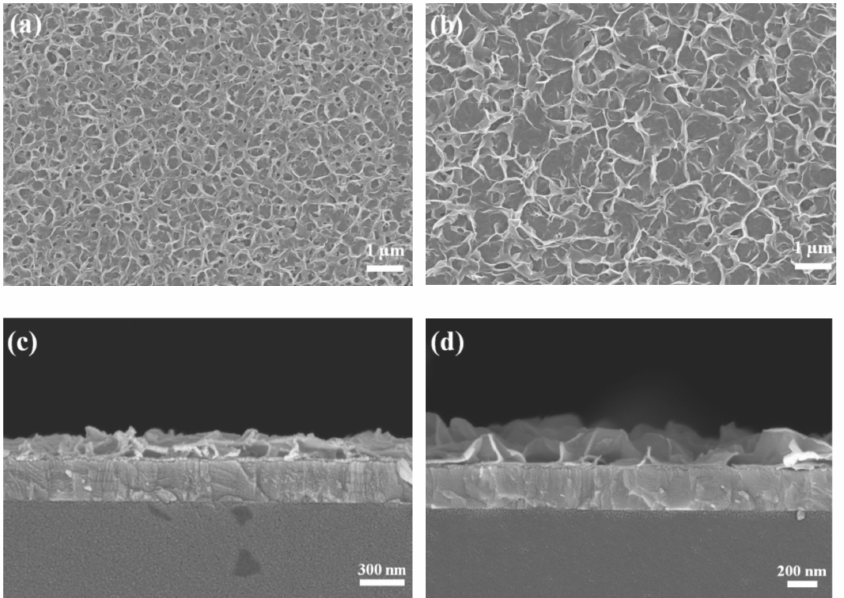
Figure 4. Top-view and cross-sectional SEM images of the Ni-doped ZnO NWLs with HMT concen- trations of ( a , c ) 3 and ( b , d ) 5 mM.